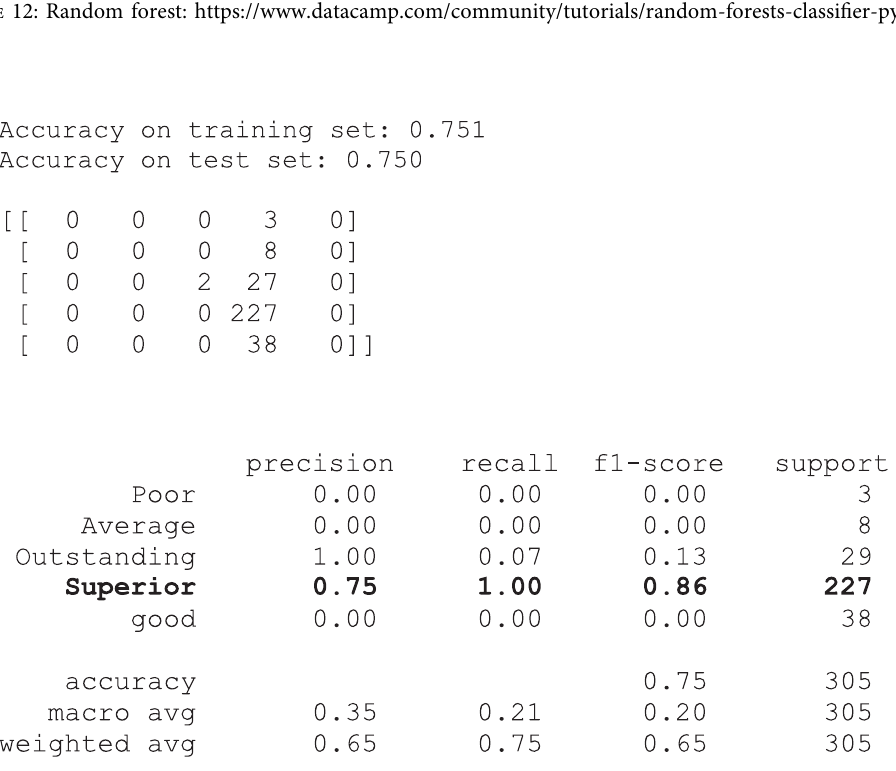
Figure 13: Random forest confusion matrix and accuracy